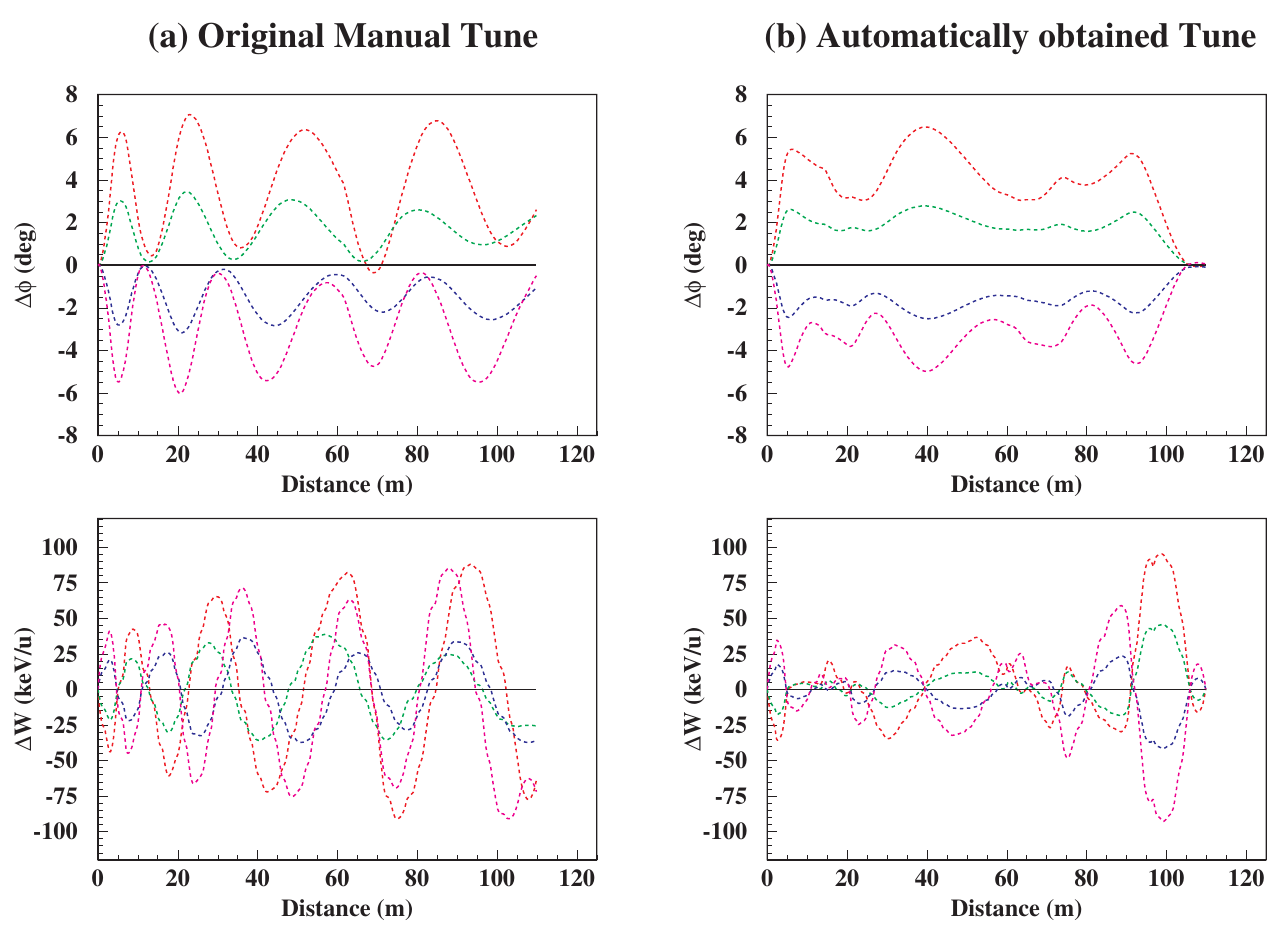
AUTOMATIC LONGITUDINAL TUNING OF A . .